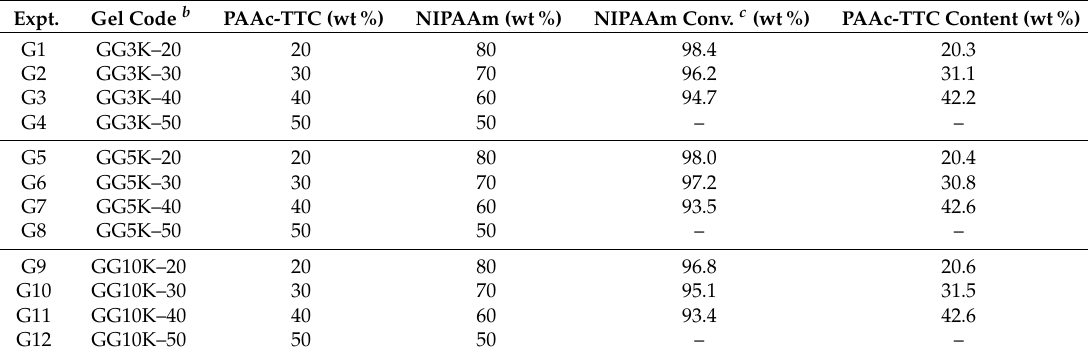
Table 2. Composition and experimental conditions for the synthesis of PNIPAAm- g -PAAc networks by RAFT polymerisation a